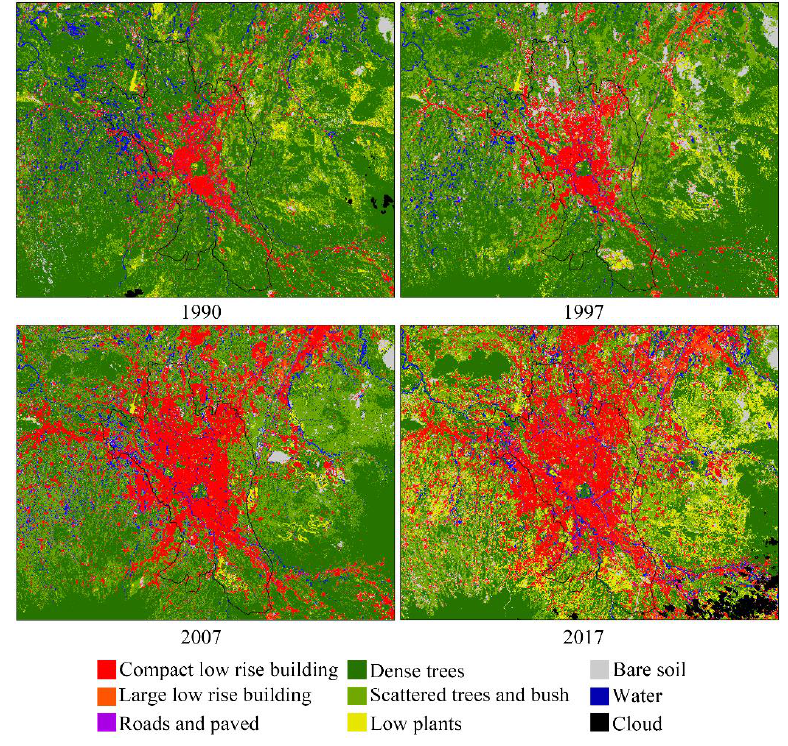
Figure 4. LCZ maps of Bogor. Table 4. LCZ results in different years (ha).